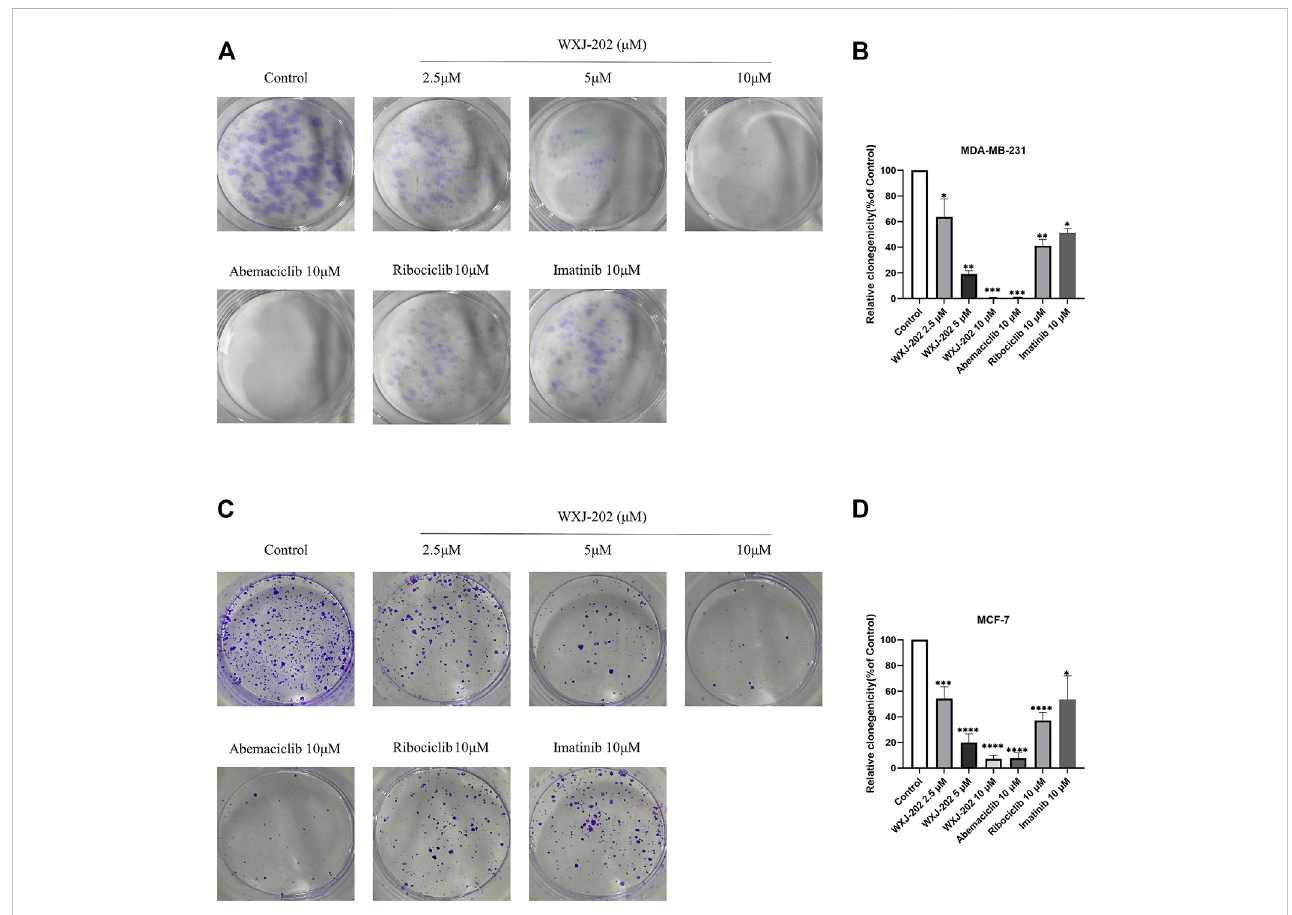
FIGURE 5 EffectsofcompoundWXJ-202oncolonyformationinMDA-MB-231cellsandMCF-7cells. (A,B) EffectsofcompoundWXJ-202,abemaciclib,ribociclib and imatinib on the proliferative capacity of MDA-MB-231 cells. (C,D) The effect of compound WXJ-202, abemaciclib, ribociclib and imatinib on the proliferative capacity of MCF-7 cells. * p < 0.05 vs. control, ** p < 0.01 vs. control, *** p < 0.001 vs. control, **** p < 0.0001 vs.